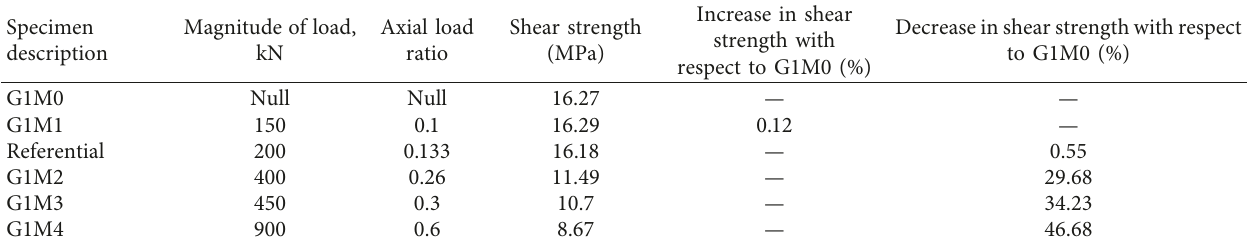
Table 6: Shear strength response of specimens with different axial load ratios.